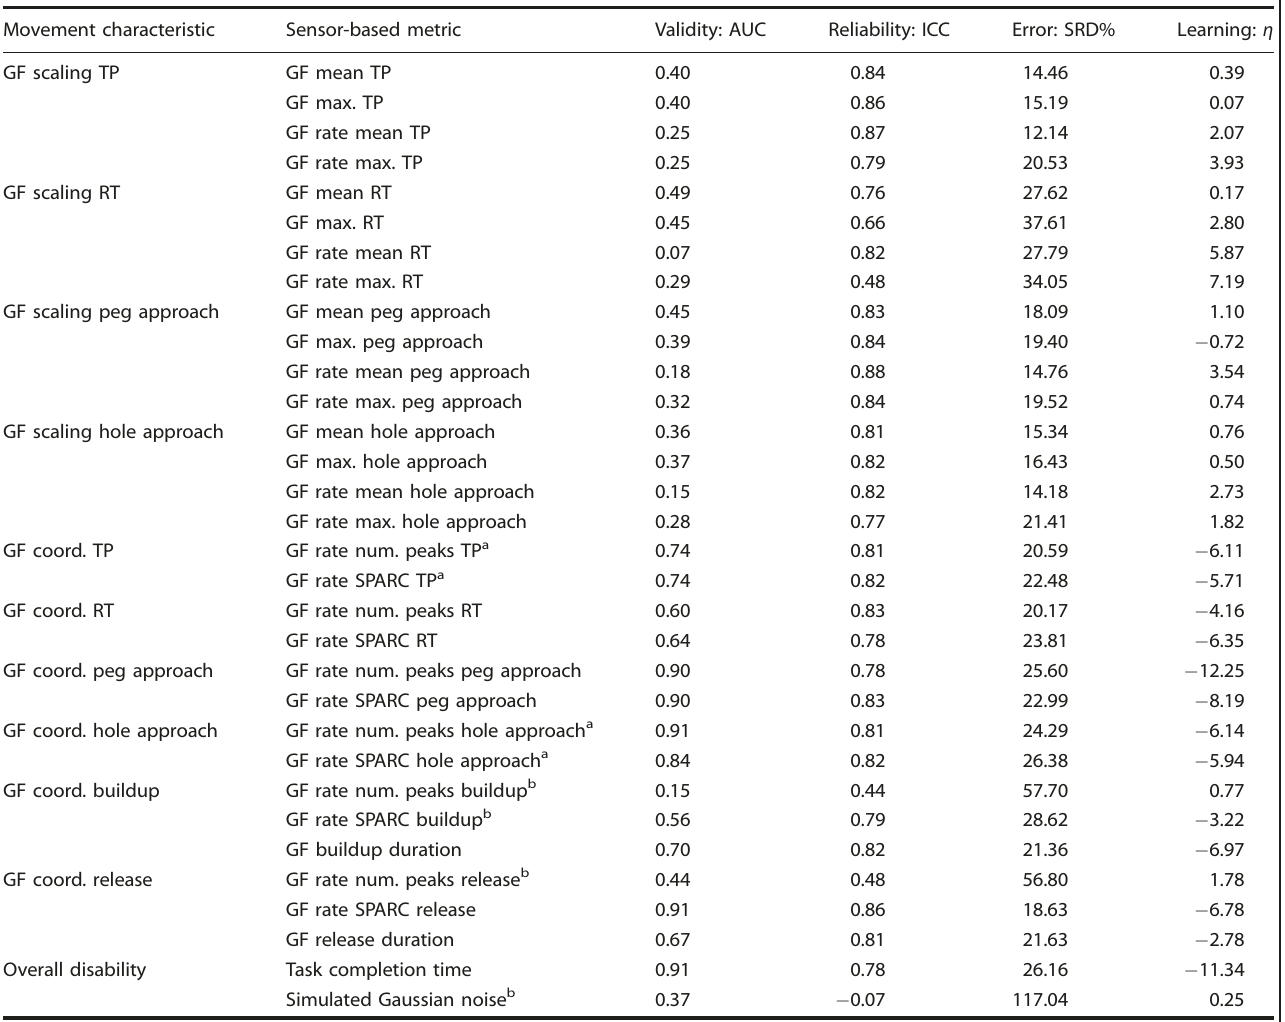
The area under the curve (AUC, optimum at 1), intraclass correlation coef fi cient (ICC, optimum at 1), the smallest real difference (SRD%, optimum at 0), and η value (optimum at 0, worst at − ∞ ) were used to describe discriminative validity, test – retest reliability, measurement error, and learning effects, respectively. The task completion time and the simulated Gaussian noise metrics were evaluated in addition to the kinetic metrics. GF grip force, TP transport, RT return, SPARC spectral arc length, num